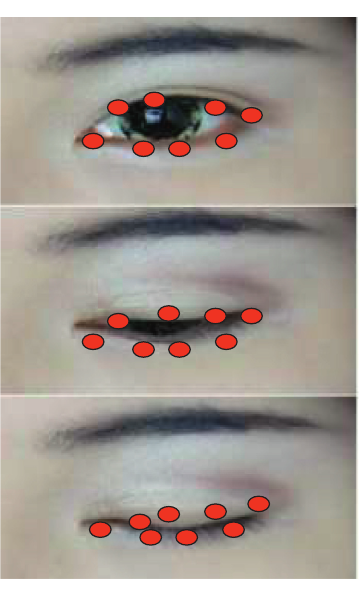
Figure 7: Typical degree of eyelid closure.